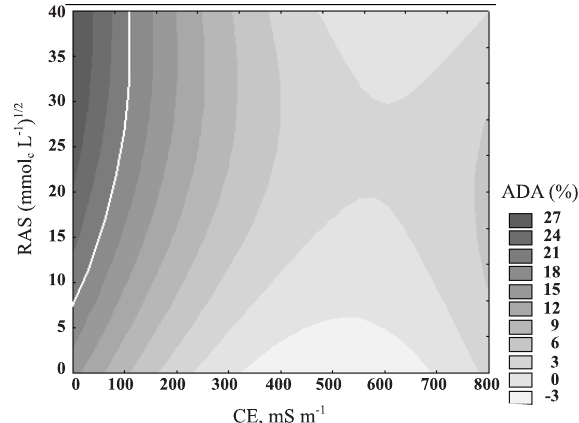
Figura 2. ADA-S em função da RAS e da CE da solução de saturação e de percolação no solo LV (hematítico), apresentando, como detalhe, curva de ADA-A obtida em amostra